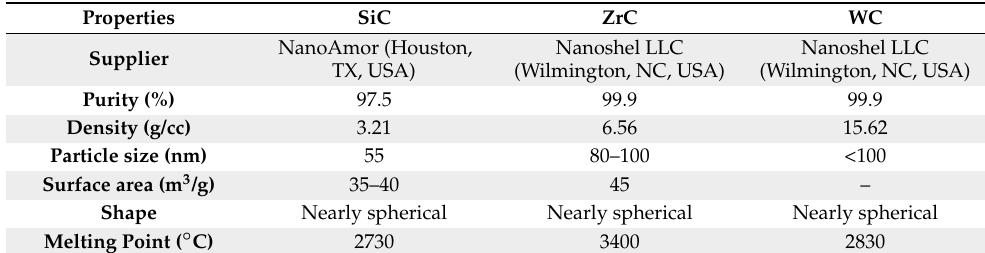
Table 1. Suppliers’ data for NPs